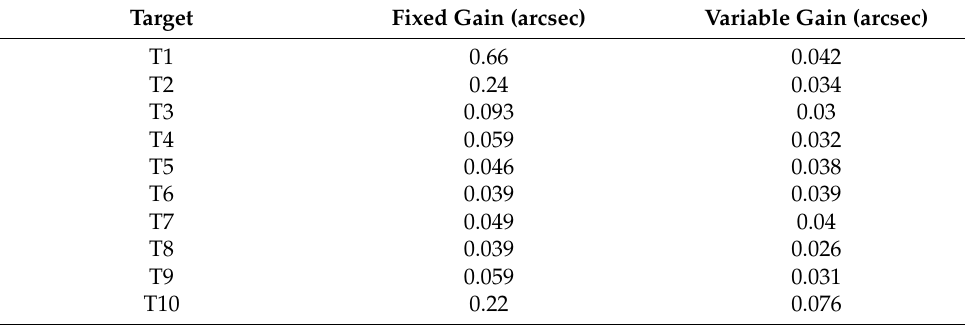
Table 1. Average tracking errors of different targets. Target Fixed Gain (arcsec) Variable Gain